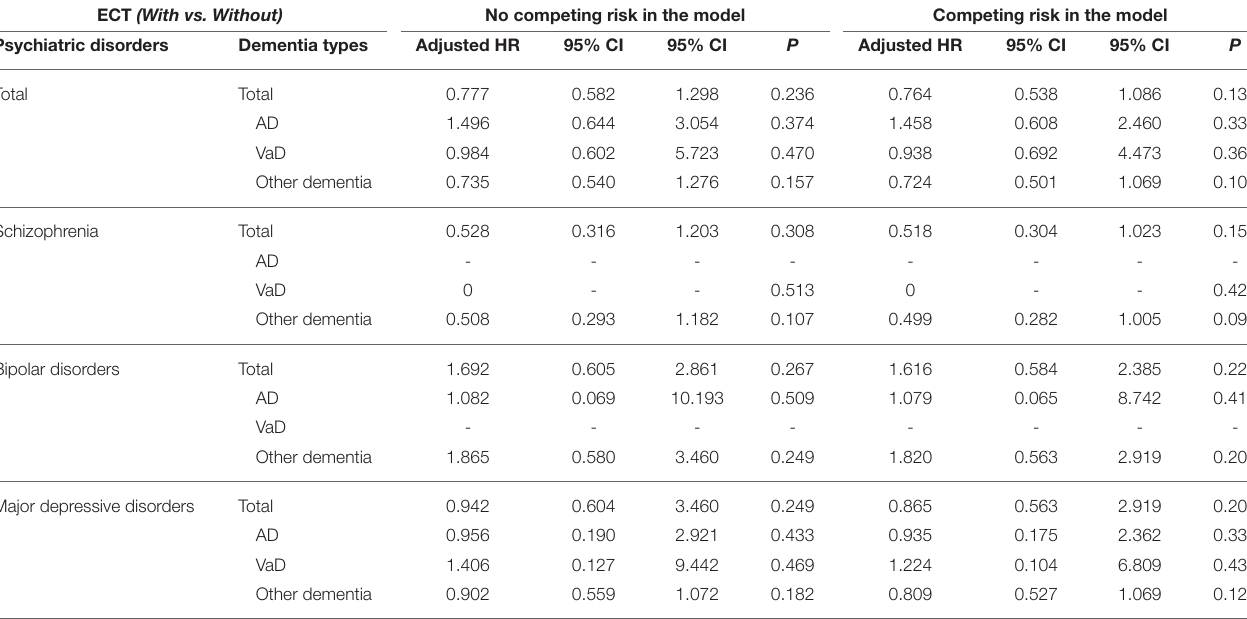
TABLE 4 | Factors of dementia subgroup stratified by study sample by using Cox regression and Fine and Gray’s competing risk model. ECT (With vs.